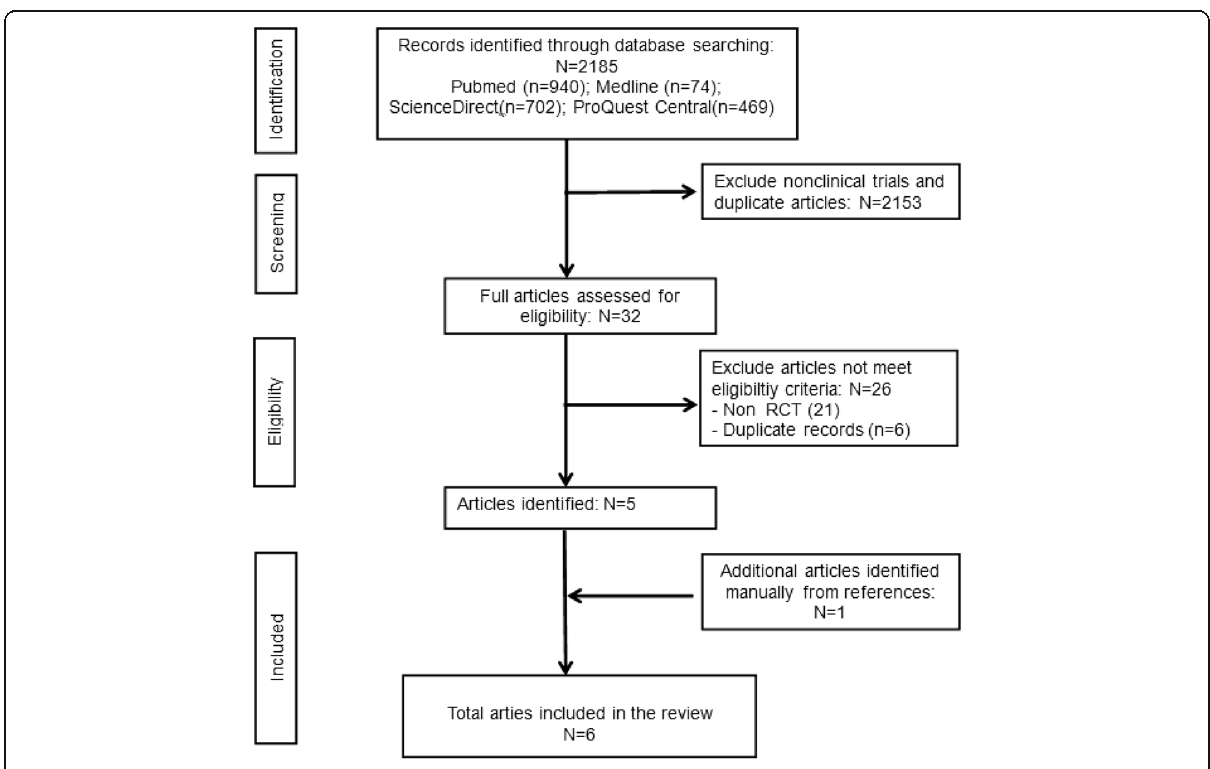
Fig. 1 Flowchart of the study selection